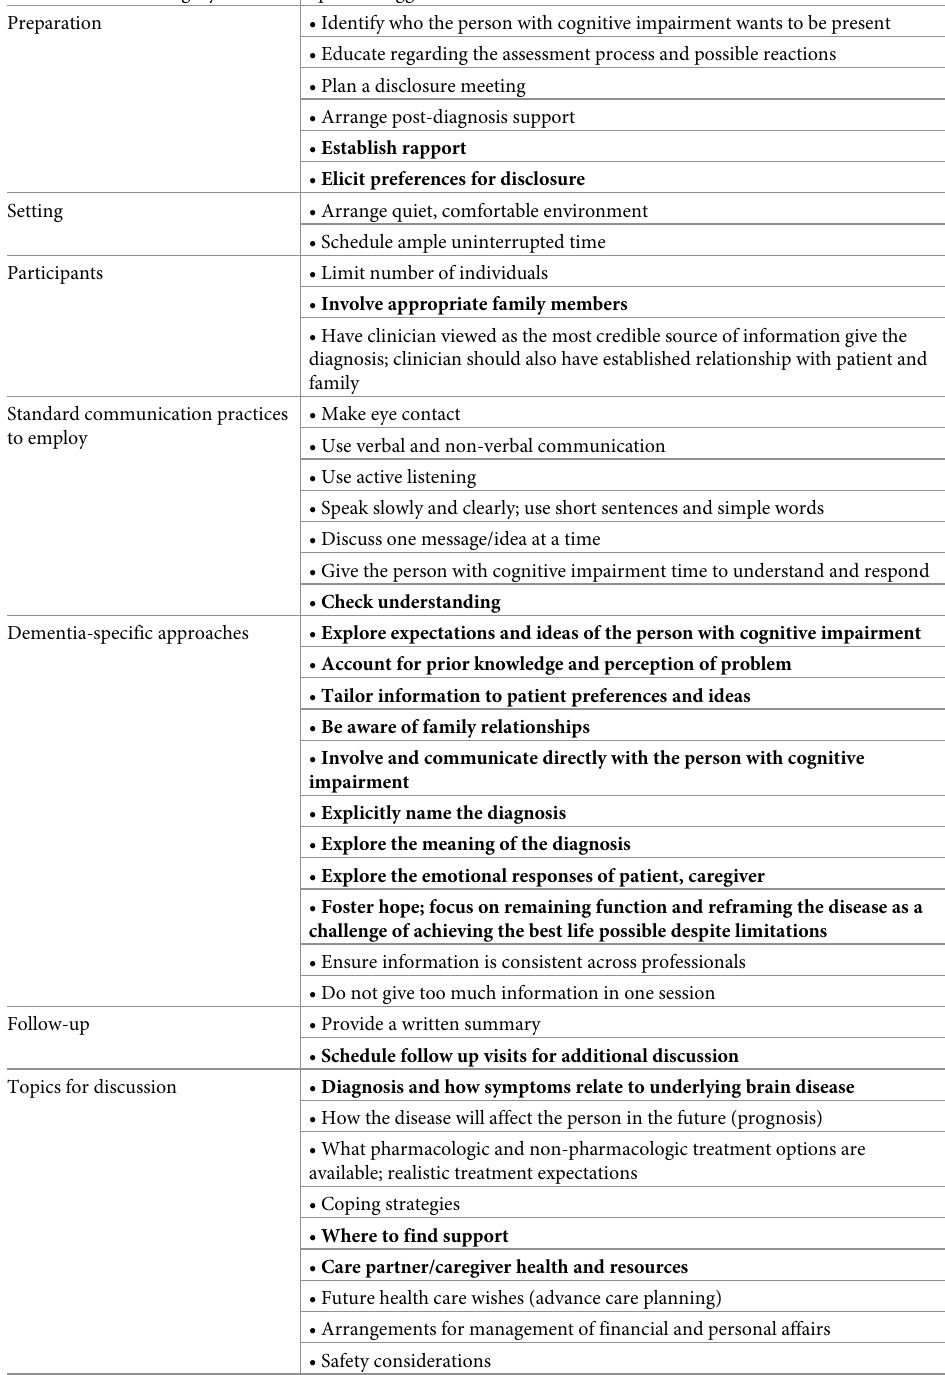
Table 2. Approaches for communicating a dementia